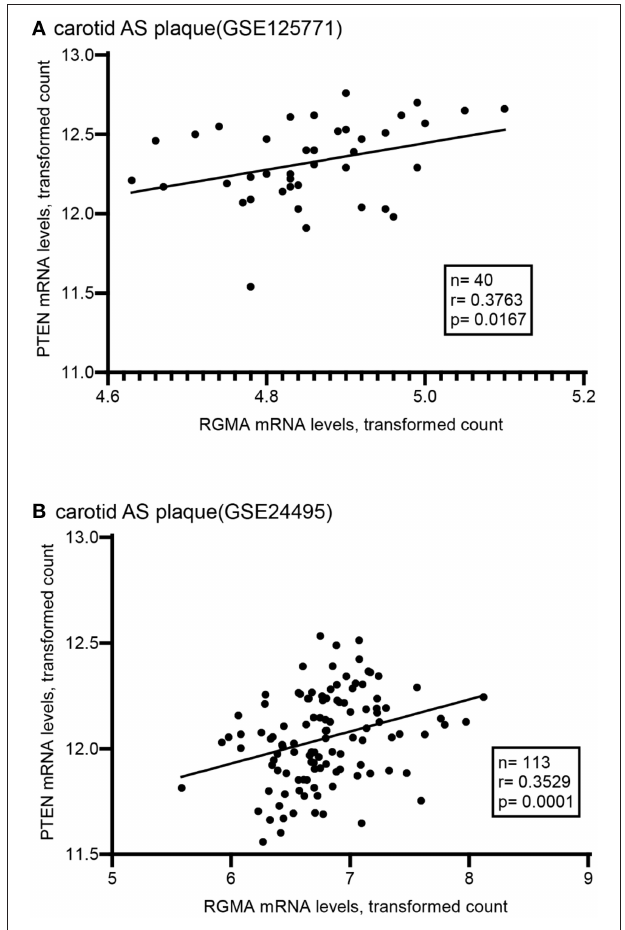
FIGURE 4 | The association of RGMA with PTEN in human carotid AS plaque. (A,B) RGMA mRNA transcription levels in carotid AS plaque positively correlated with PTEN mRNA levels in the two independent datasets from GEO database ( A according to GSE125771, B according to GSE24495). The correlation was tested by spearman’s rank test ( A : r = 0.3763, p = 0.0167; B : r = 0.3529, p = 0.0001).